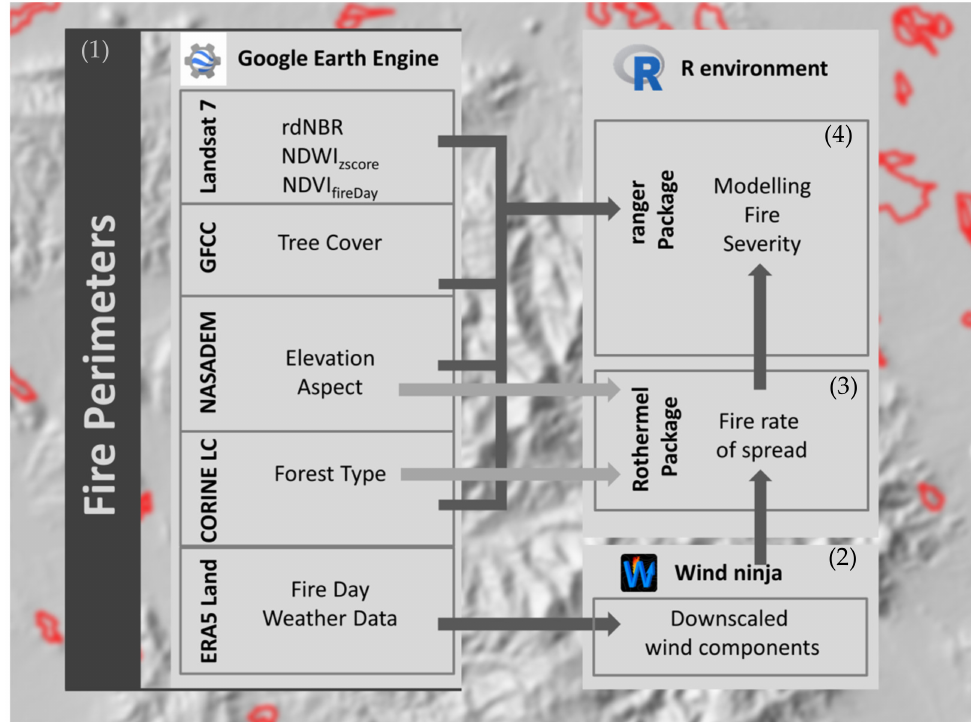
Figure 3. Data processing workflow. Fire perimeters are used to extract information in Google Earth Engine, at pixel level, regarding surface reflectance (to calculate the spectral indices), topography within the fire perimeter, vegetation characteristics (type and cover), and wind conditions during each fire event (1). Wind conditions are downscaled to the rdNBR grid using WindNinja (2). These data, together with the corresponding topographical conditions and Corine land cover class, are used to feed the Rothermel package in R to calculate the potential rate of spread for each pixel within each fire perimeter (3). Finally, the random forest algorithm is used to calibrate and validate an empirical fire severity model using the ranger Package in R